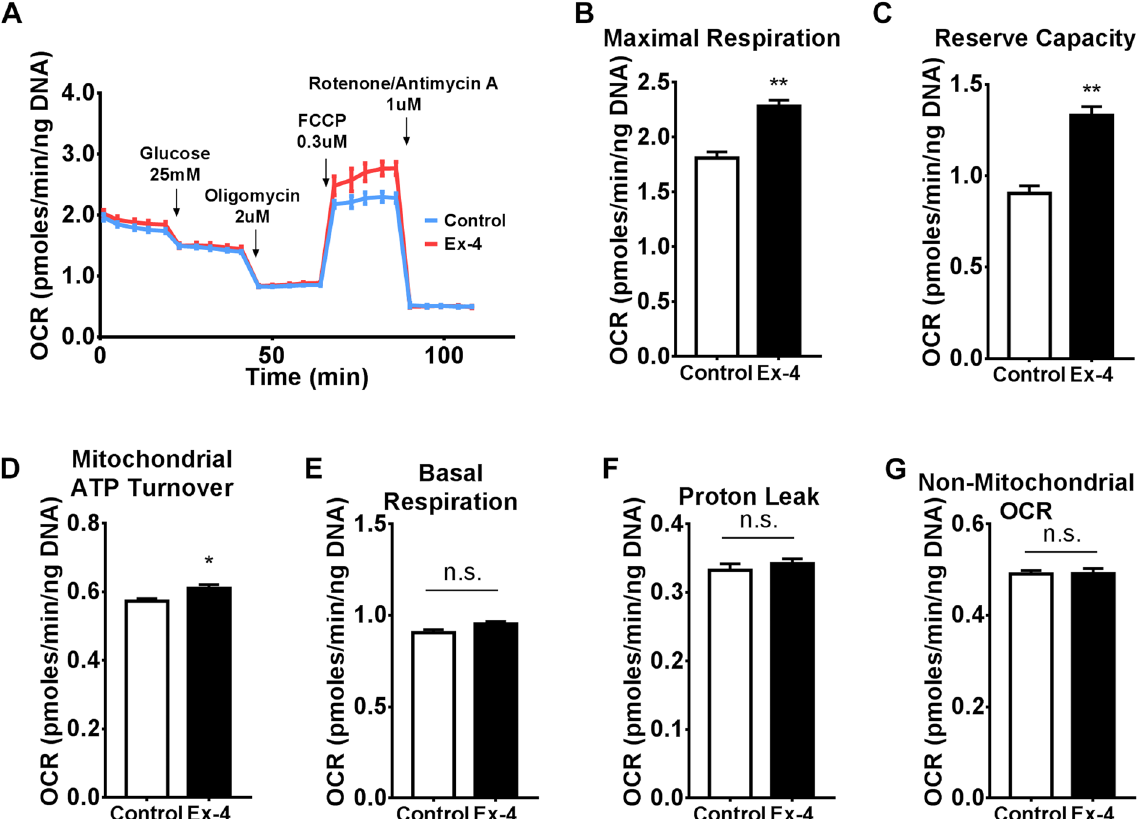
Figure 4. Maximal respiration and reserve capacity are increased after 18 h exposure to Exendin-4. ( A ) Following 18 h of incubation in the presence or absence of 50 nM Exendin-4, BRIN-BD11 cells were subjected to extracellular flux analysis. OCR was determined sequentially after injection of 25 mM glucose followed by a set of mitochondrial inhibitors (2 µ M oligomycin, 0.3 µ M FCCP and 1 µ M each of rotenone and antimycin A) to generate a mitochondrial stress profile. ( B – G ) Mitochondrial parameters were calculated from the mitochondrial stress profile as described in Methods. ( B ) Maximal respiration, ( C ) reserve capacity, ( D ) mitochondrial ATP turnover, ( E ) basal respiration, ( F ) proton leak, ( G ) non-mitochondrial OCR. Data represent mean ± SEM, n = 3; n.s. = non-significant; * P < 0.05; ** P <